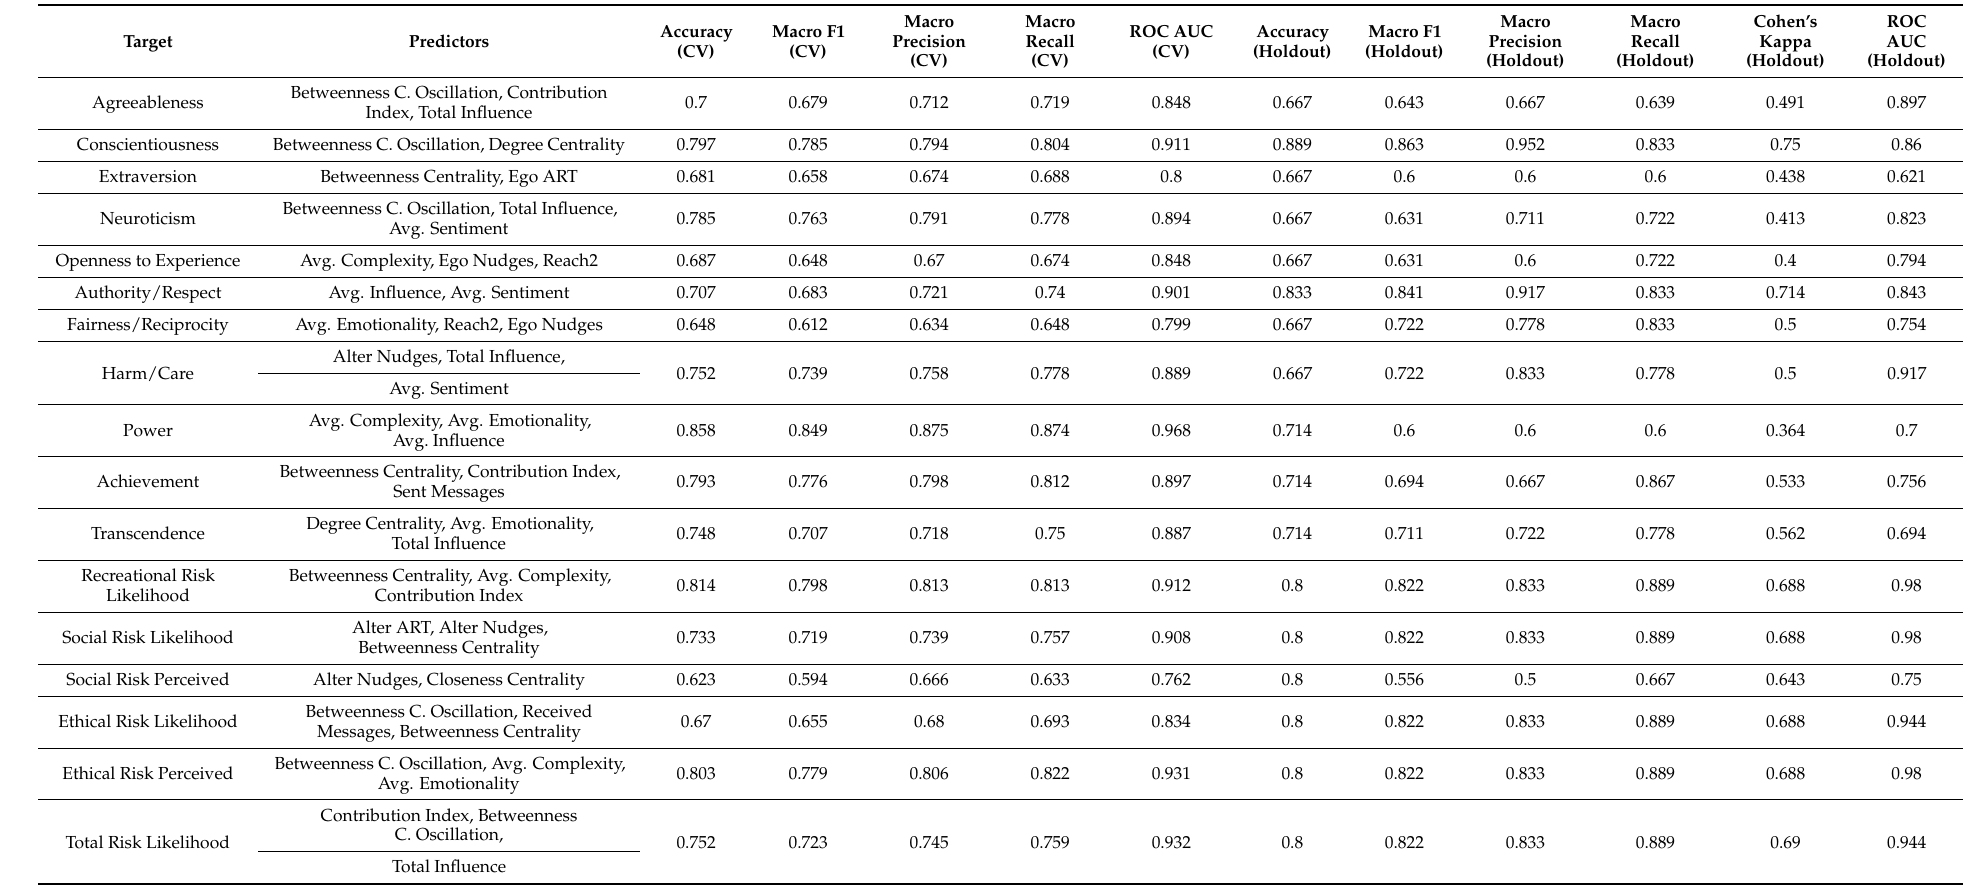
Table 4. Prediction Models for Personal and Moral